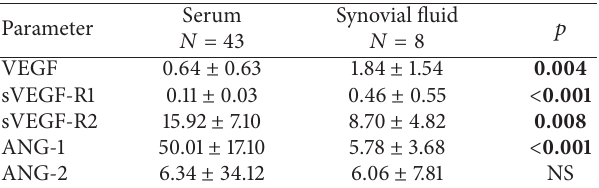
Table 4: Comparison between angiogenic protein levels in periph- eral serum and synovial